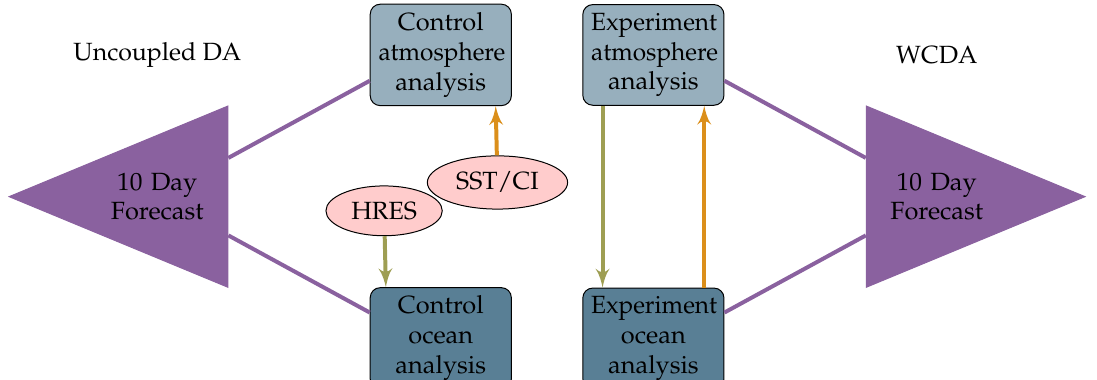
Figure 5. Schematic of experimental design. On the right is the experiment, with the weakly coupled DA passing information between atmosphere and ocean analyses. On the left is the control atmospheric analysis getting its SST and sea ice concentration (CI) from the external OSTIA product, with the forcing field for the control ocean analysis coming from the operational HRES